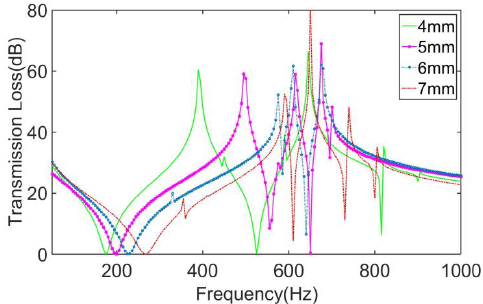
Figure 12. Comparison of the MAMs with different mass positions.